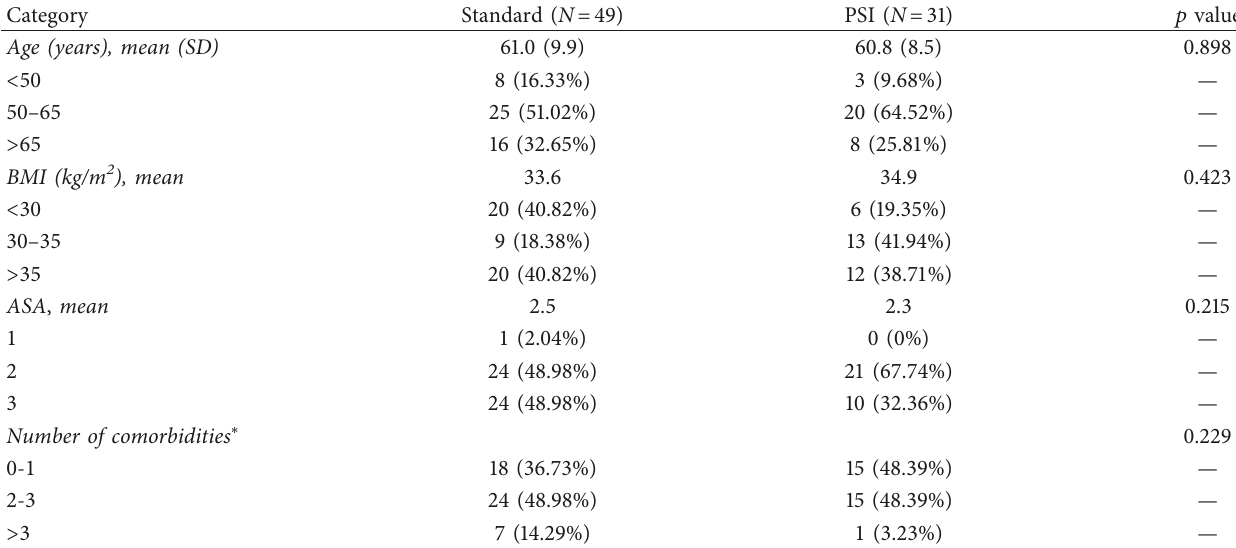
Table 1: Demographic characteristics between